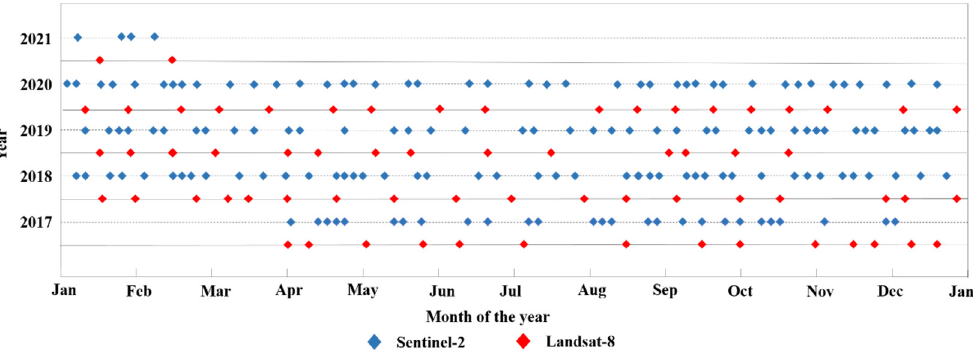
Figure 2. Temporal coverage of the Sentinel-2 and Landsat-8 time series data used in this study.